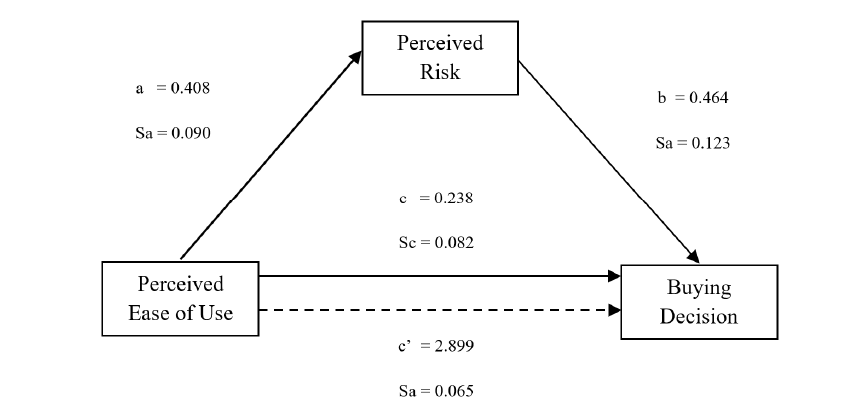
Fig. 6. The result of Sobel test for mediating role of perceived risk for perceived ease of use and consumer buying decision Fig. 6 shows the Sobel test result for mediating the role of perceived risk for perceived ease of use and consumer buying decision. The result produces a value of the statistical test is 2.897 or higher than 1.96, and the p-value is 0.003 < 0.01 and a standard error of 0.065. Thus, perceived risk partially mediates the relationship between perceived ease of use and consumer buying decision. Therefore, the proposed hypothesis is supported. Also, Fig. 7 captures the step-by-step summary of hypothesis testing.